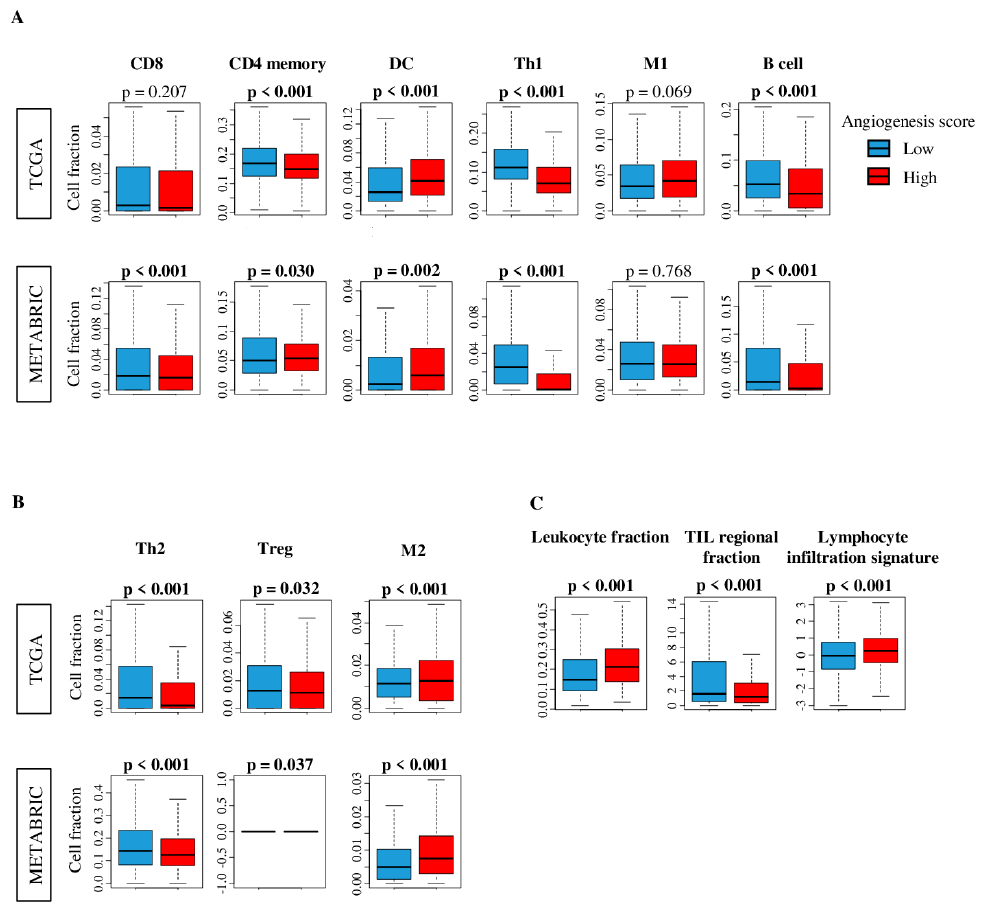
Figure 4. Comparison of tumor infiltrating immune cells between low (blue) and high (red) angiogenesis score tumors. Boxplots of the comparison with ( A ) favorable immune cells: CD8, CD4 memory, dendritic cell (DC), T helper type 1 cells (Th1), M1 macrophages, and B cell, and ( B ) unfavorable immune cells: T helper type 2 cells (Th2) , regulatory T cell (Treg), and M2 macrophage by low and high angiogenesis scores in the TCGA and METABRIC cohorts. ( C ) Comparison of low and high angiogenesis scores in scores of leukocyte fraction, tumor infiltrating lymphocyte (TIL)